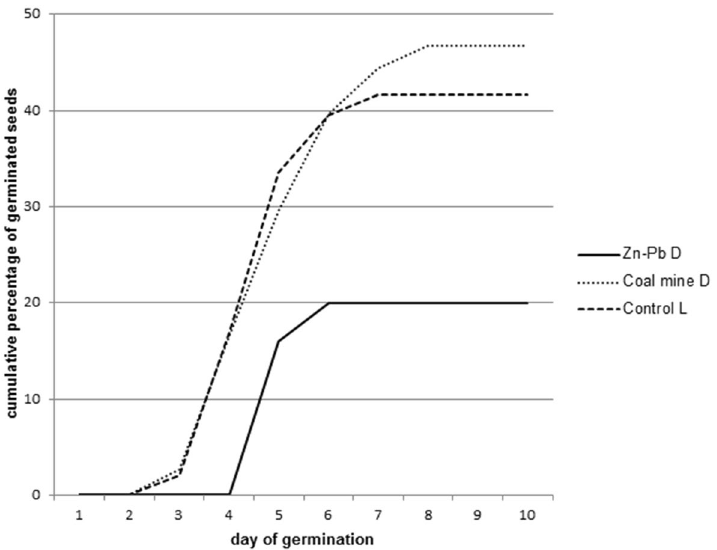
Figure 3. Cumulative percentage of germinated seeds during the 14 days of the experiment on the polluted Zn-Pb D, Coal mine D and the control site (Control